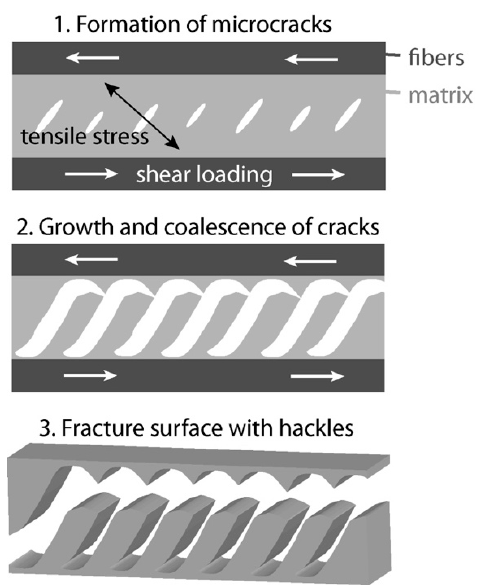
Figure 2. Fracture mechanism in fiber-reinforced composites under mode II loading: hackling.